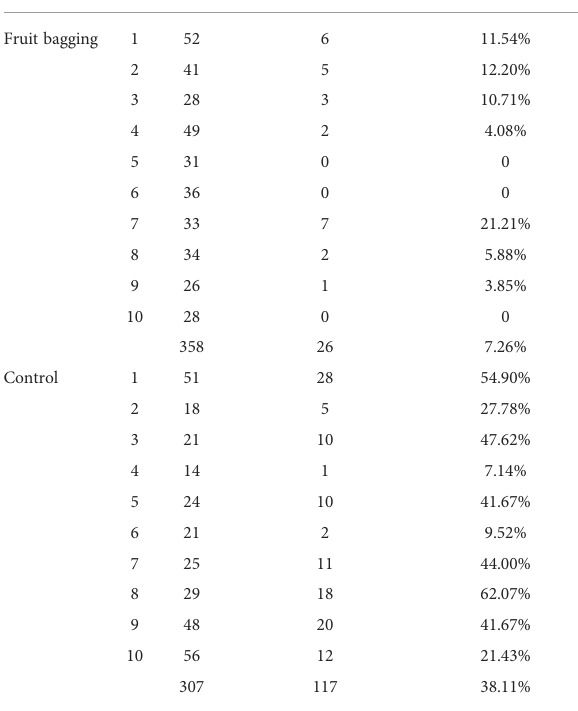
TABLE 1 The incidence of fruit cracking under the bagging treatment and